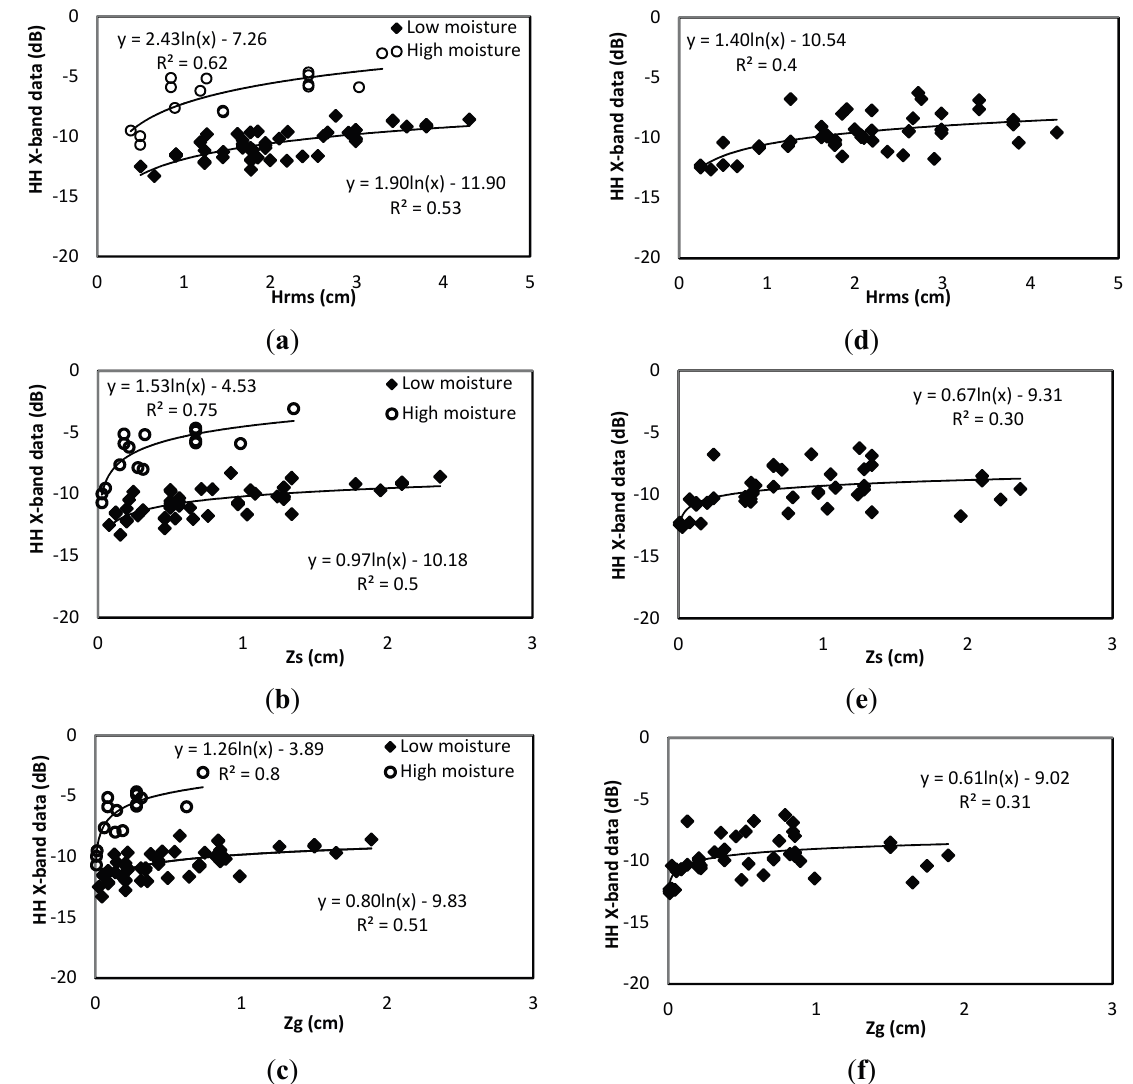
Figure 5. Relationship between X-band SAR signals in the HH polarization and the soil roughness parameters Hrms , Zs , and Zg . The data was recorded at 36° incidence, for low and high values of soil moisture ( a – c ), and at 26° incidence, for low moisture values only (no high moisture at 26° incidence acquisition dates) ( d – f